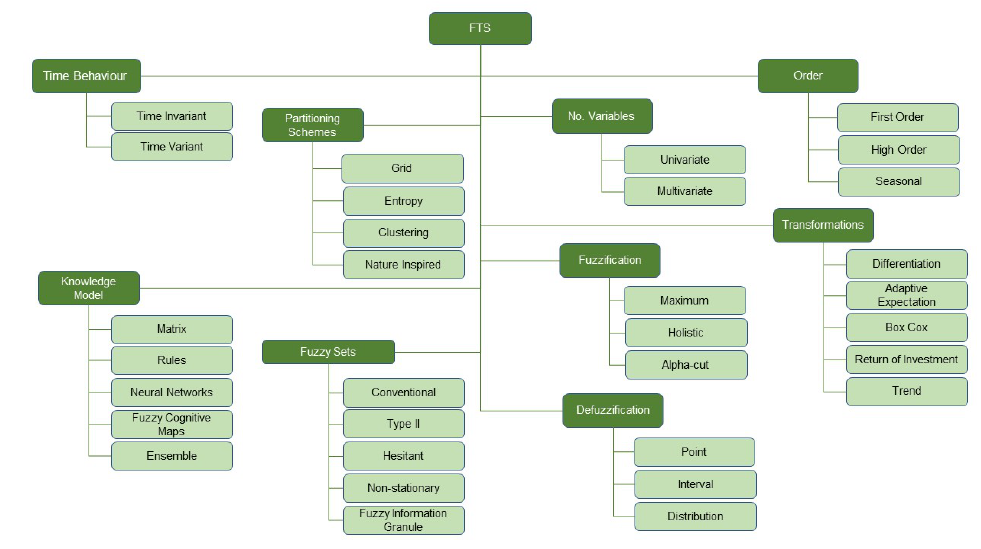
Figure 1. A taxonomy of FTS models